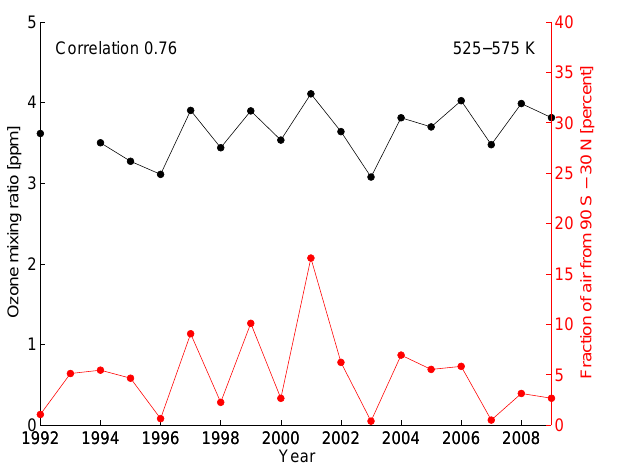
Fig. 7. Time series of vortex mean ozone mixing ratios at 525– 575K in early winter (30 December–8 January, 1992–2009, black), superimposed by a time series of the fraction of air in the polar vortex at 525–575K which is originating from 70–75 ◦ N equivalent latitude on 1 September (red).